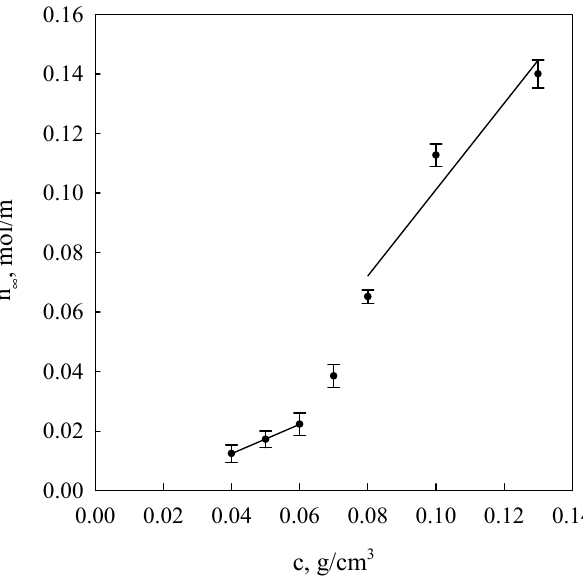
Figure 3. Concentrational relationships of starch gel segment equilibrium concentrations ( n ∞ ) at different concentrations starch in systems. The values are expressed as means ± SD ( n = 3).